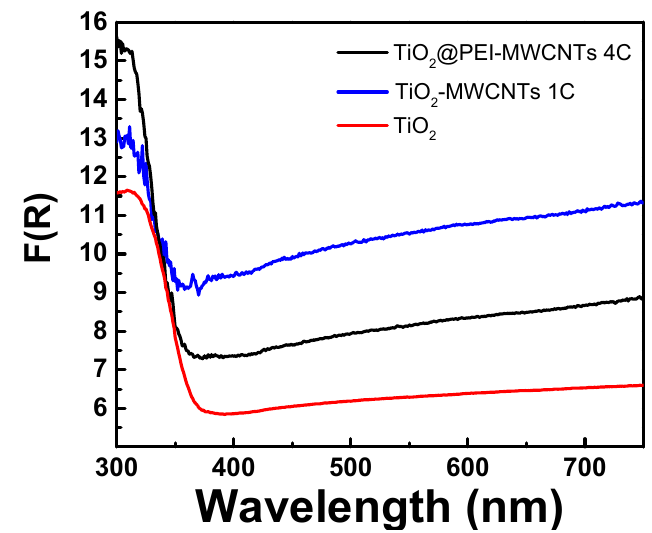
Figure 5. Absorbance spectra in Kubelka-Munk units of photocatalytic materials.